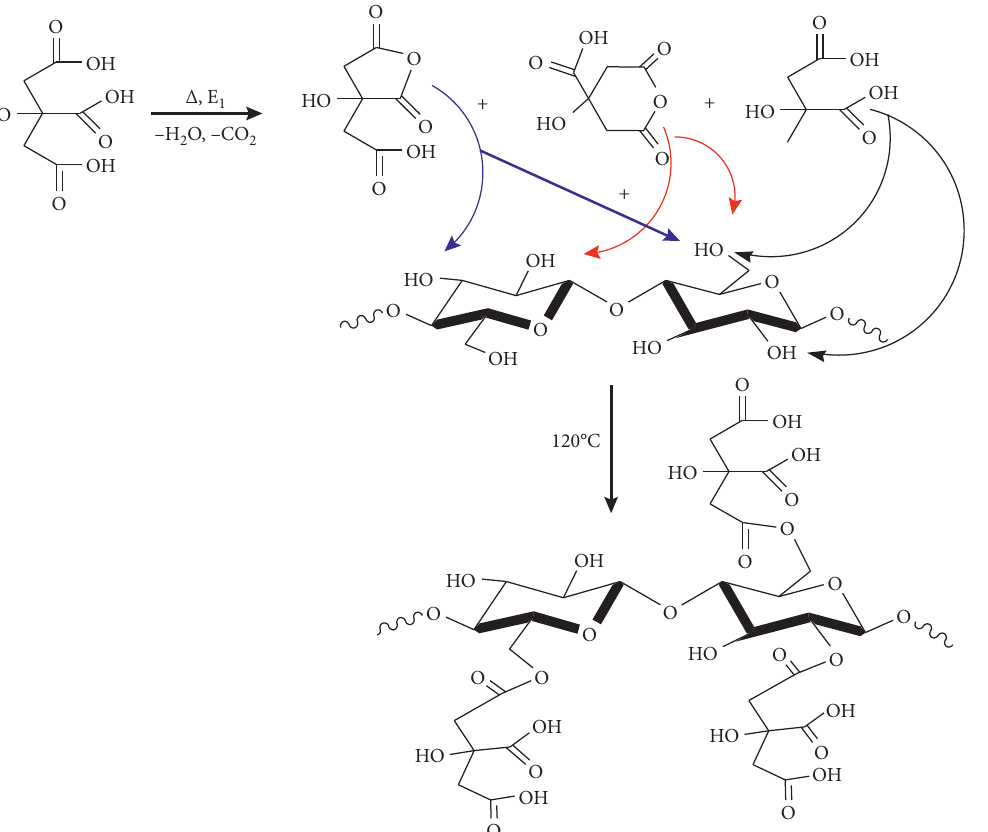
Figure 1: Modification reaction of CA with the hydroxyl –OH groups of the cellulose